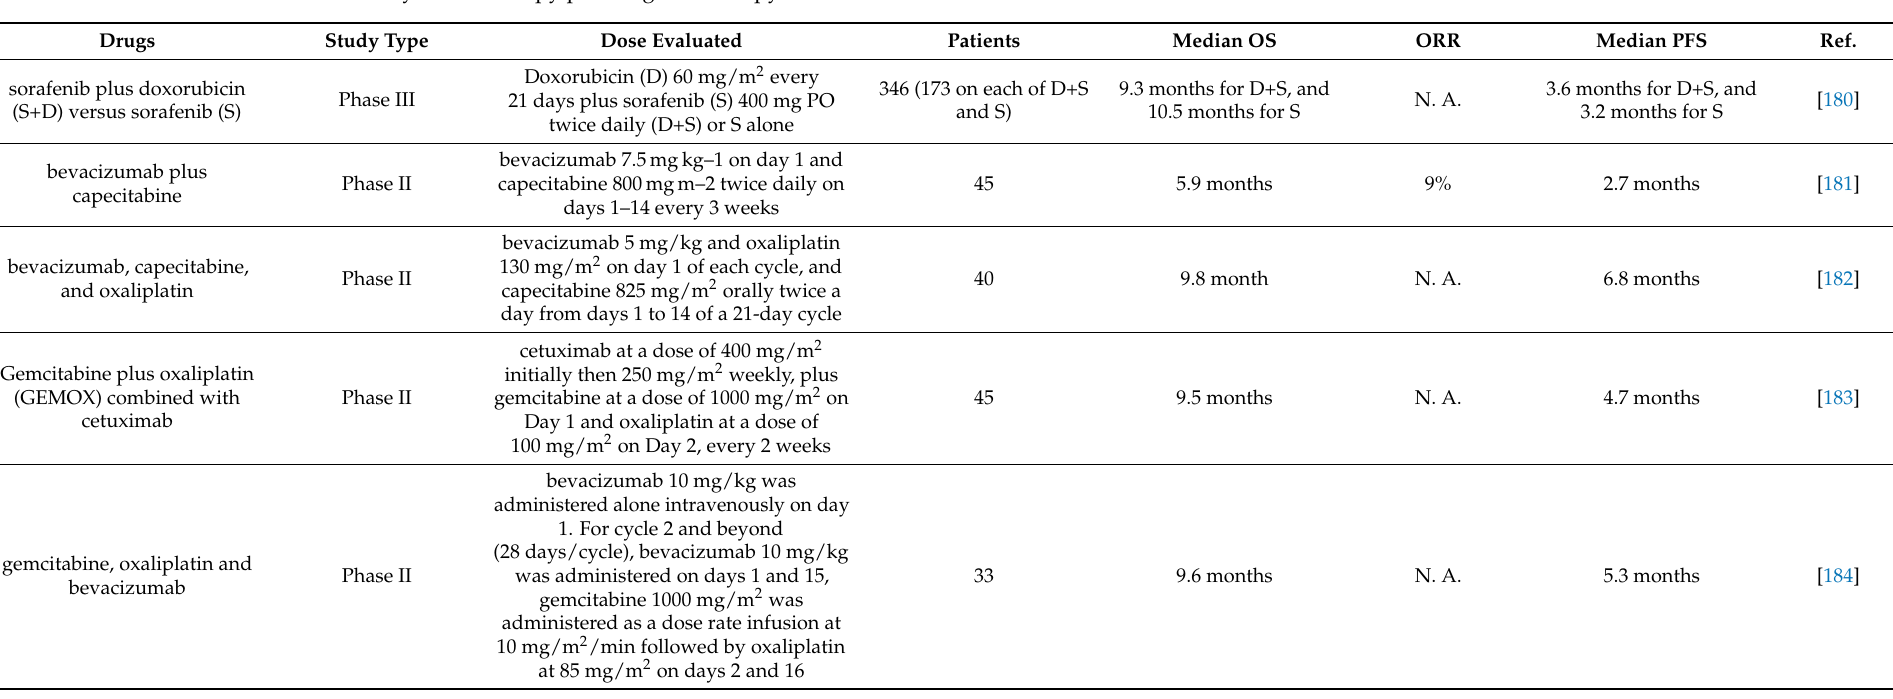
Table 3. Systemic therapy plus targeted